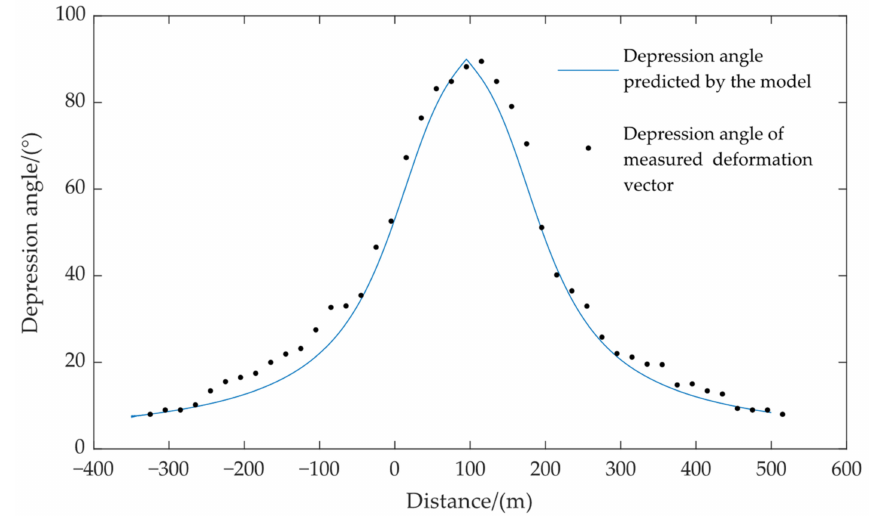
Figure 10. Example verification of the depression angle